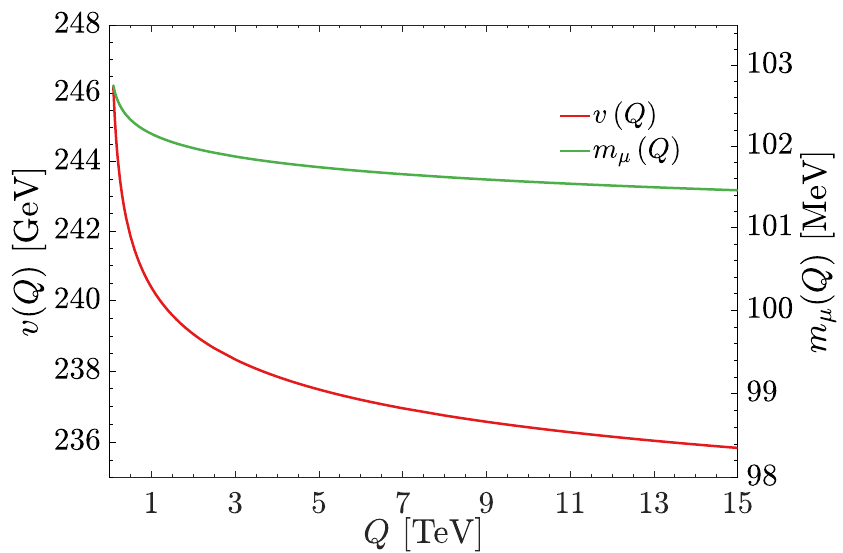
Figure 2 . LO RGE running of SM vacuum expectation value v (left scale) and muon mass m µ (right scale) as functions of the energy scale Q